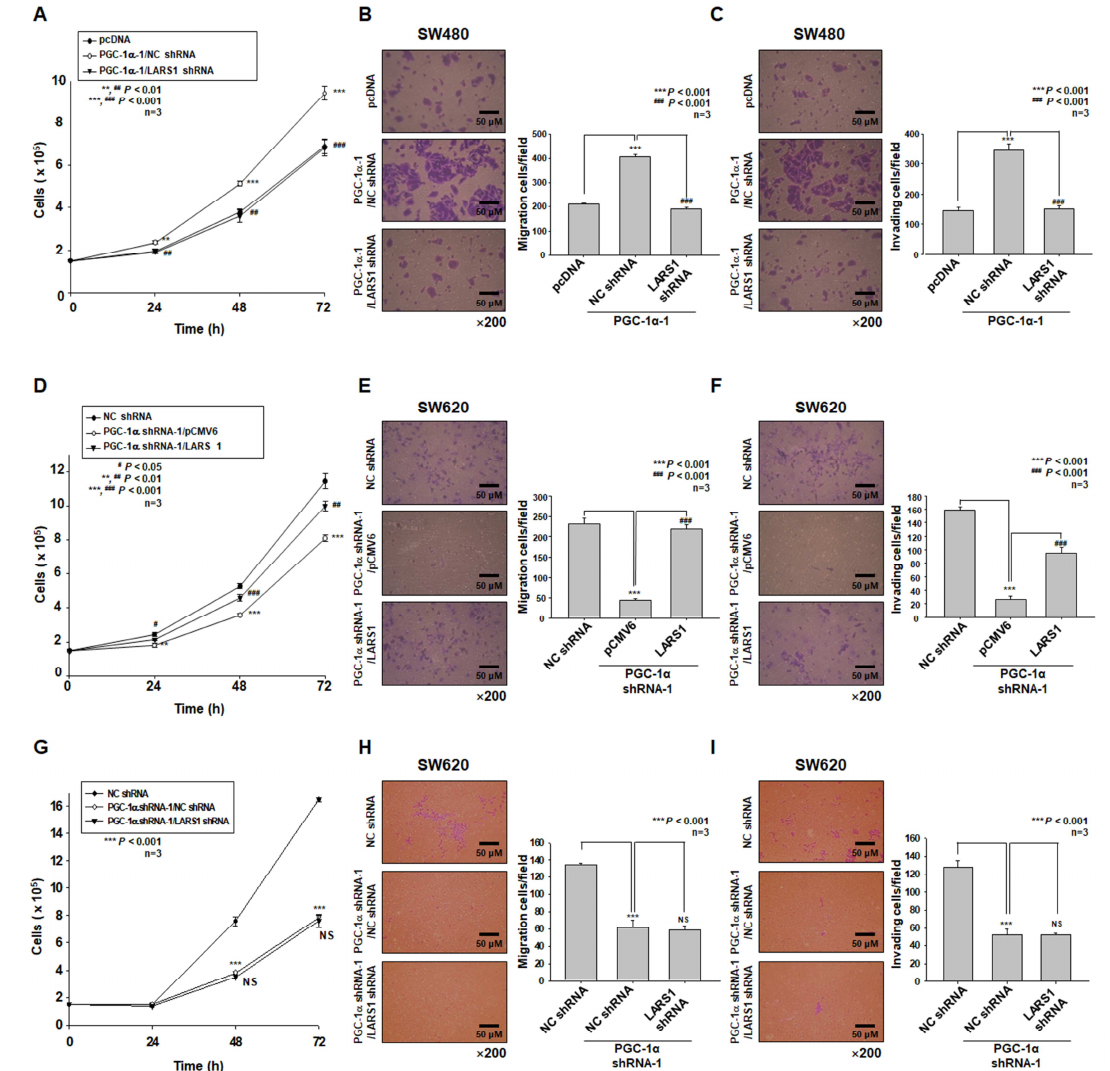
cell counting ( B ) and MTT assay ( C ). Data are presented as the mean ± SD of three separate experi- ments. * p < 0.05, ** p < 0.01, *** p < 0.001 vs. NC shRNA-SW620 cells. ( D , E ) Left panel: Representative figures of NC shRNA- and LARS1 shRNA-5-SW620 cells in the transwell migration assay ( D ) and transwell invasion assay ( E ) are shown ( × 200 magnification). Right panel: The numbers of transmem- brane migrated cells ( D ) and transmembrane invaded cells ( E ) are shown. Data are expressed as the mean ± SD of three independent experiments. *** p < 0.001 vs. NC shRNA-SW620 cells. Molecular weights for proteins are indicated in the full, uncropped, annotated Western blot images (Figure S5).